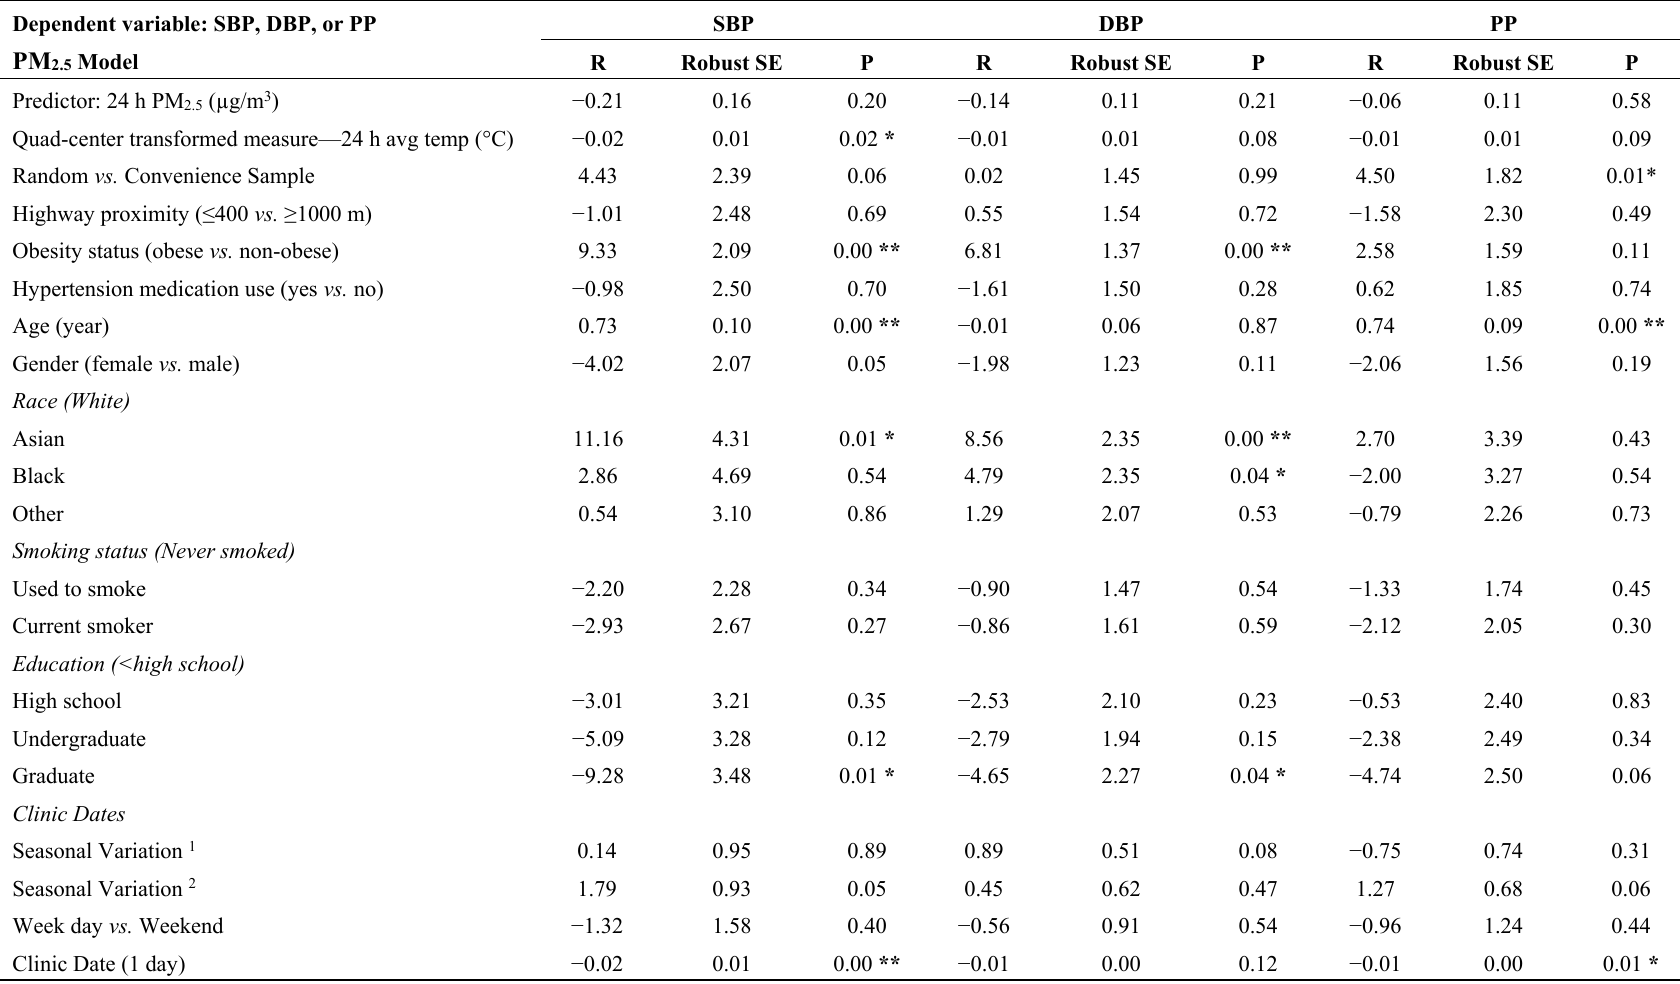
Table 5. Linear Mixed Model of PM 2.5 (number of observations = 436 in 243